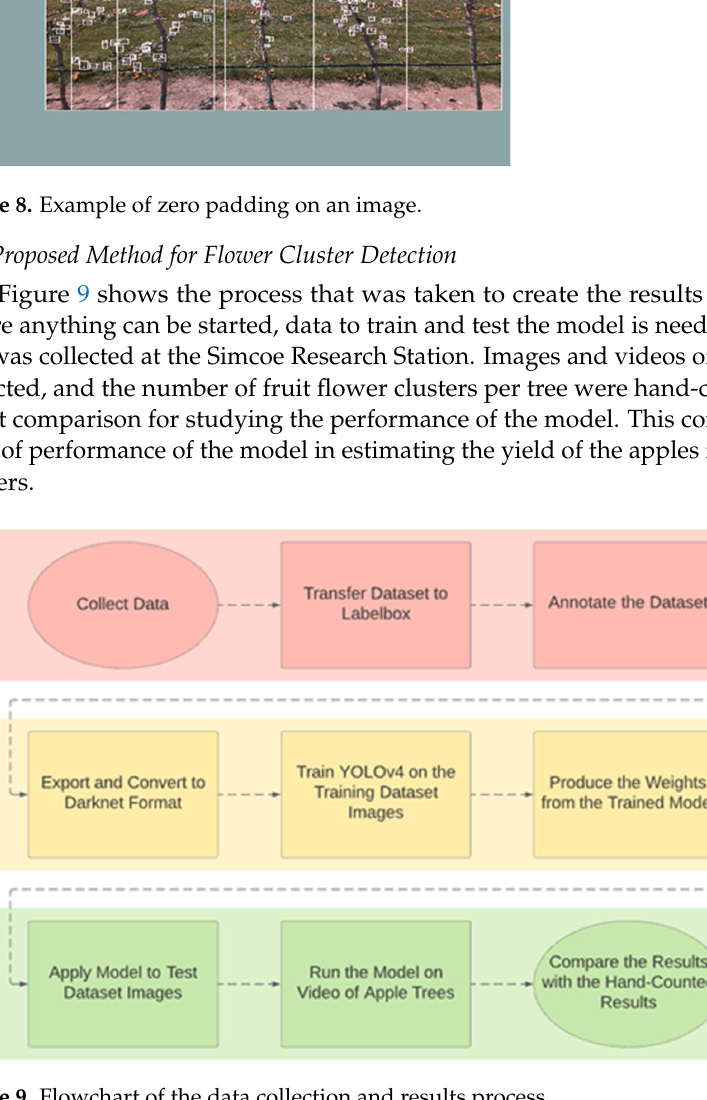
Figure 9. Flowchart of the data collection and results process.